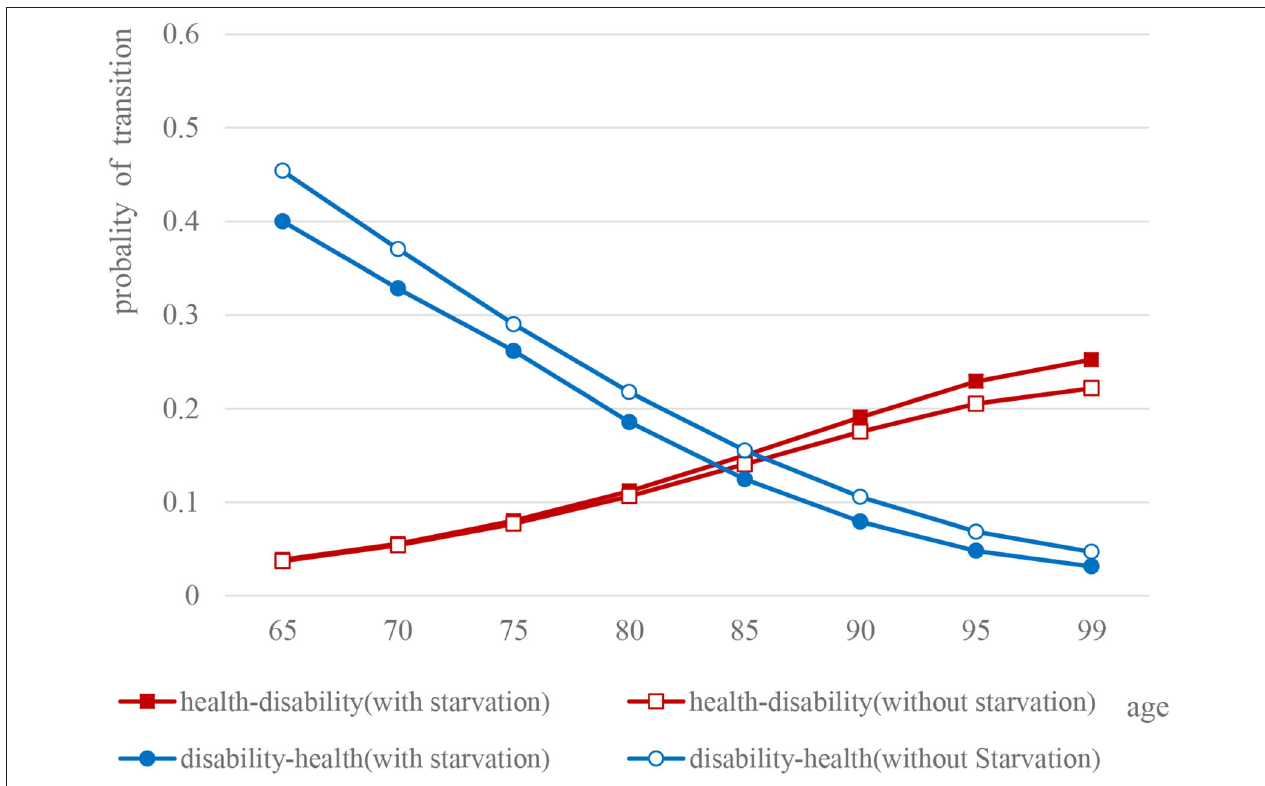
FIGURE 2 | Comparison of the probability curves of disability and health transition among elderly males.